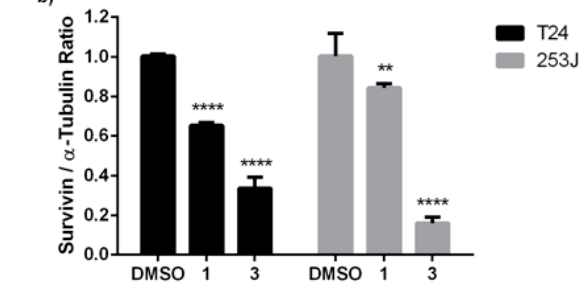
Figure 10. Expression profile of survivin in T24 and 253 J cells treated with compounds 1 and 3 . ( a ) Protein expression of survivin from Western blot analysis. α -Tubulin was used as an internal control for total protein measurement. ( b ) Survivin/ α -Tubulin ratio of the Western blot analysis. The graph represents the mean ± standard deviation of three independent experiments. Statistical analysis was carried out using two-way ANOVA followed by a Bonferroni multiple comparison test with ** p < 0.01 and **** p <